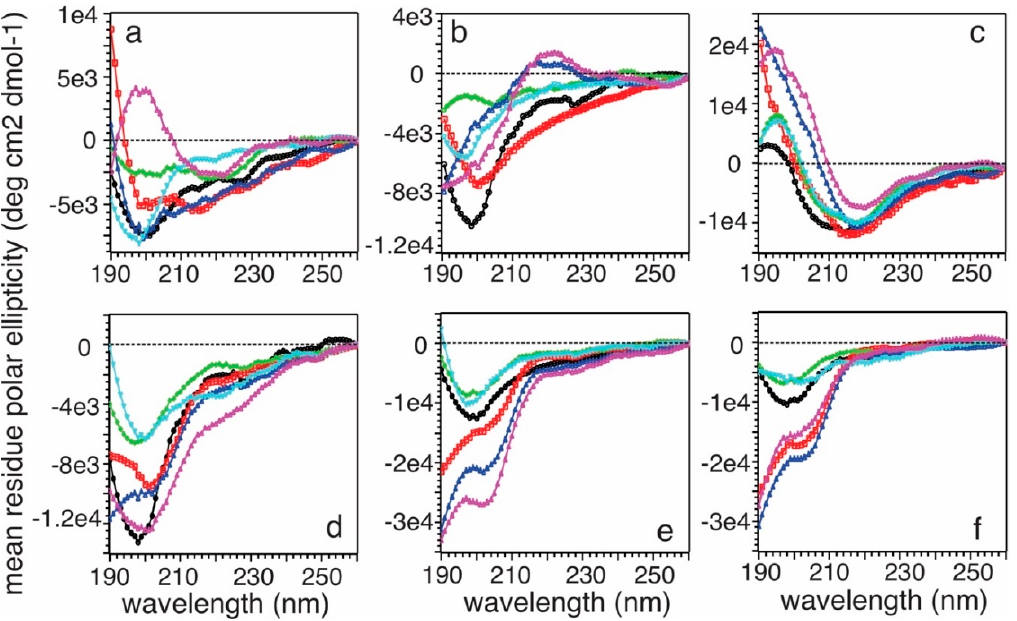
Figure 9. CD spectra for total and free A β 40 peptides with di ff erent incubation times: ( a , d ) 0 h, ( b , e ) 5 h, ( c , f ) 10 h. Di ff erent color-codings were utilized for di ff erent model membranes: black, PC; red, PC / chol; blue, PC / S; purple, PC / S / chol; green, PC / S / E; dark navy, PC / S / E / chol.